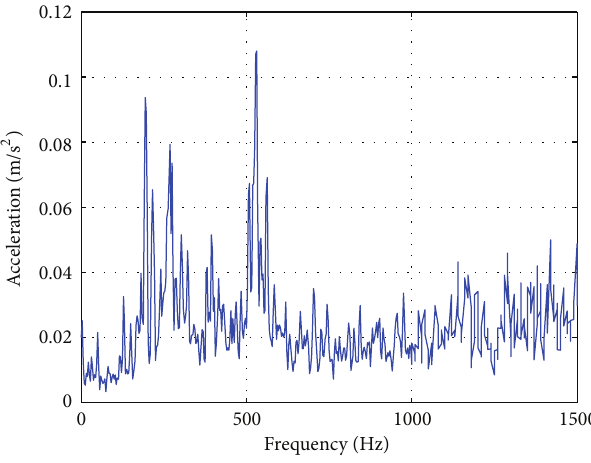
Figure 9: Spectrogram of vibration accelerations of motor cover.